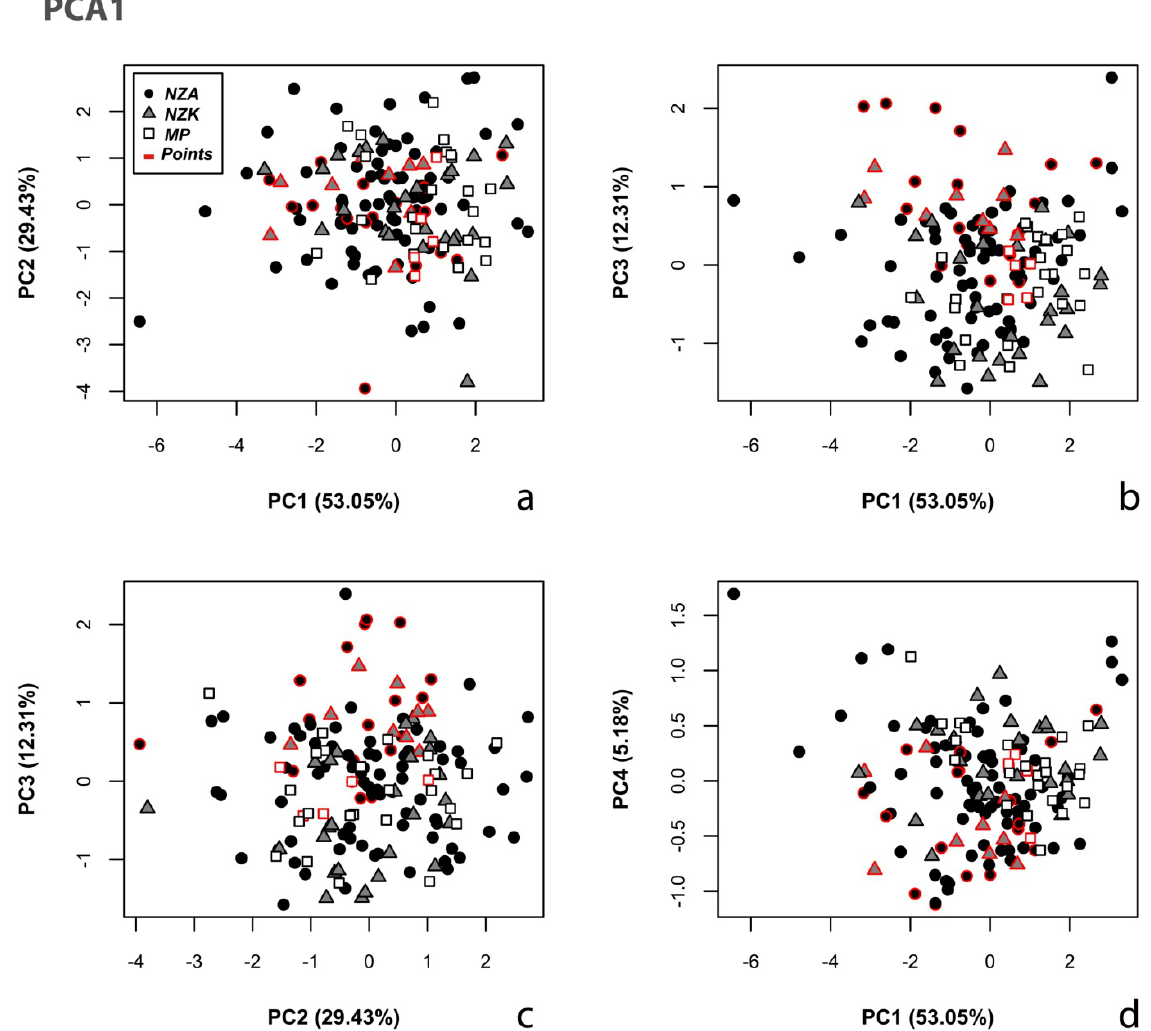
Figure 11. PCA1 - Plot of the scores of the first four PCs of the PCA realised on the five indices (fineness, robustness and elongation indices (see Table 1)). The results for this PCA are in Table 5. Symbols represent different sites (circles: NZA, triangles: NZK, squares: MP) and red outlines indicate Lupemban points.